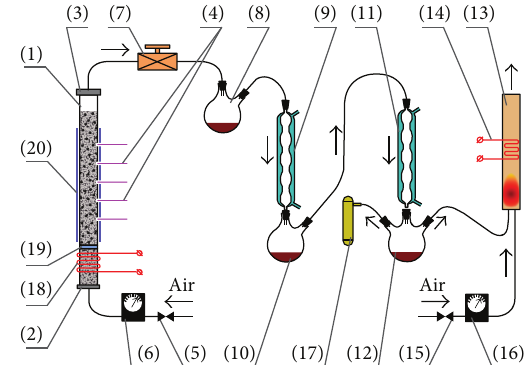
Figure 1: Schematic of the experimental setup. (1) Reactor; (2), (3) upper and bottom flanges of the reactor; (4) thermocouples; (5), (15) valve; (6), (16) flowmeter; (7) tar separator; (8), (10), and (12) flasks for liquid products; (9), (11) water coolers; (13) afterburner; (14), (18) electric heaters; (17) sample of gaseous products; (19) igniter composition; (20) radiation